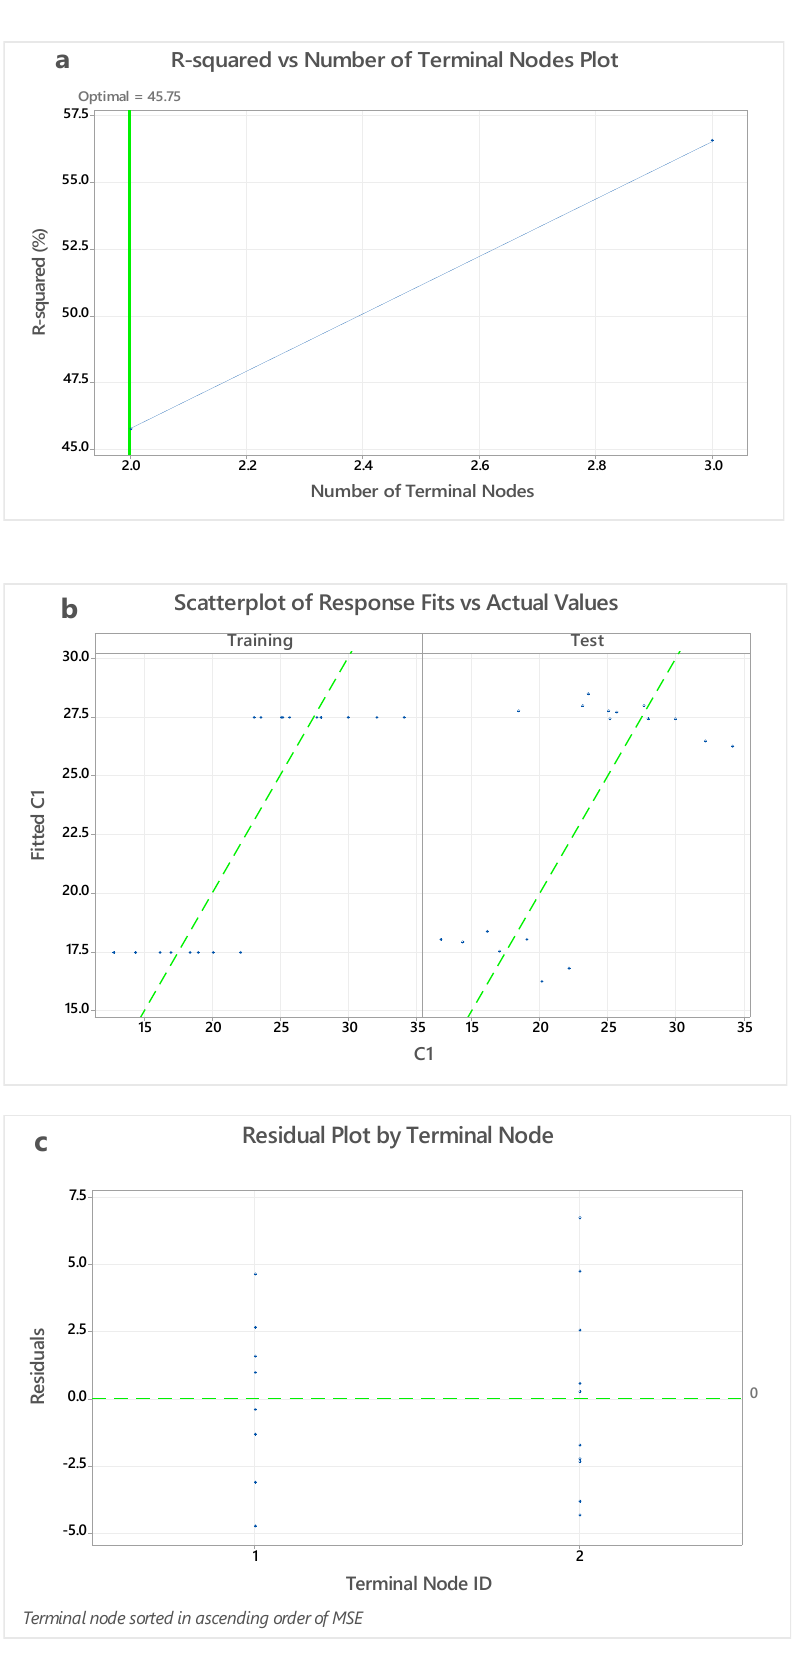
Figure 8. ( a ) Variation of R-squared and number of terminal nodes, ( b ) variation of scatterplot of response fits vs. actual values, and ( c ) variation residual plot by terminal node.